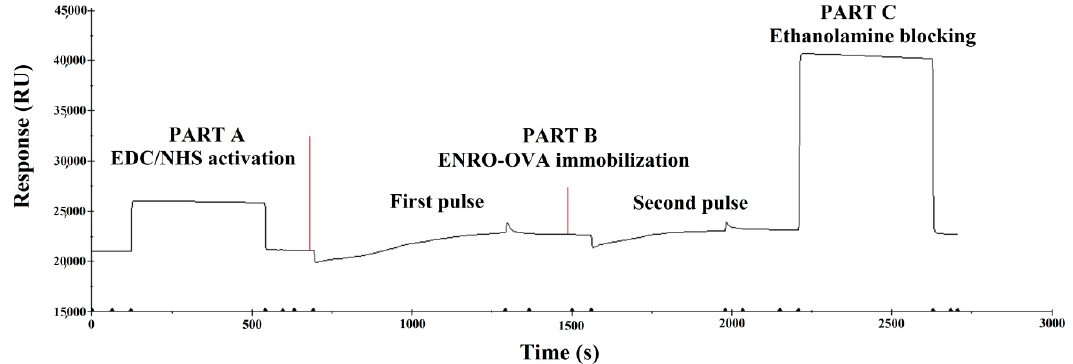
Figure 4. The immobilization of ENRO-OVA conjugate on the SPR chip surface. PART A: EDC/NHS activation process, PART B: ENRO-OVA immobilization (two binding pulses), PART C: Ethanolamine blocking process.